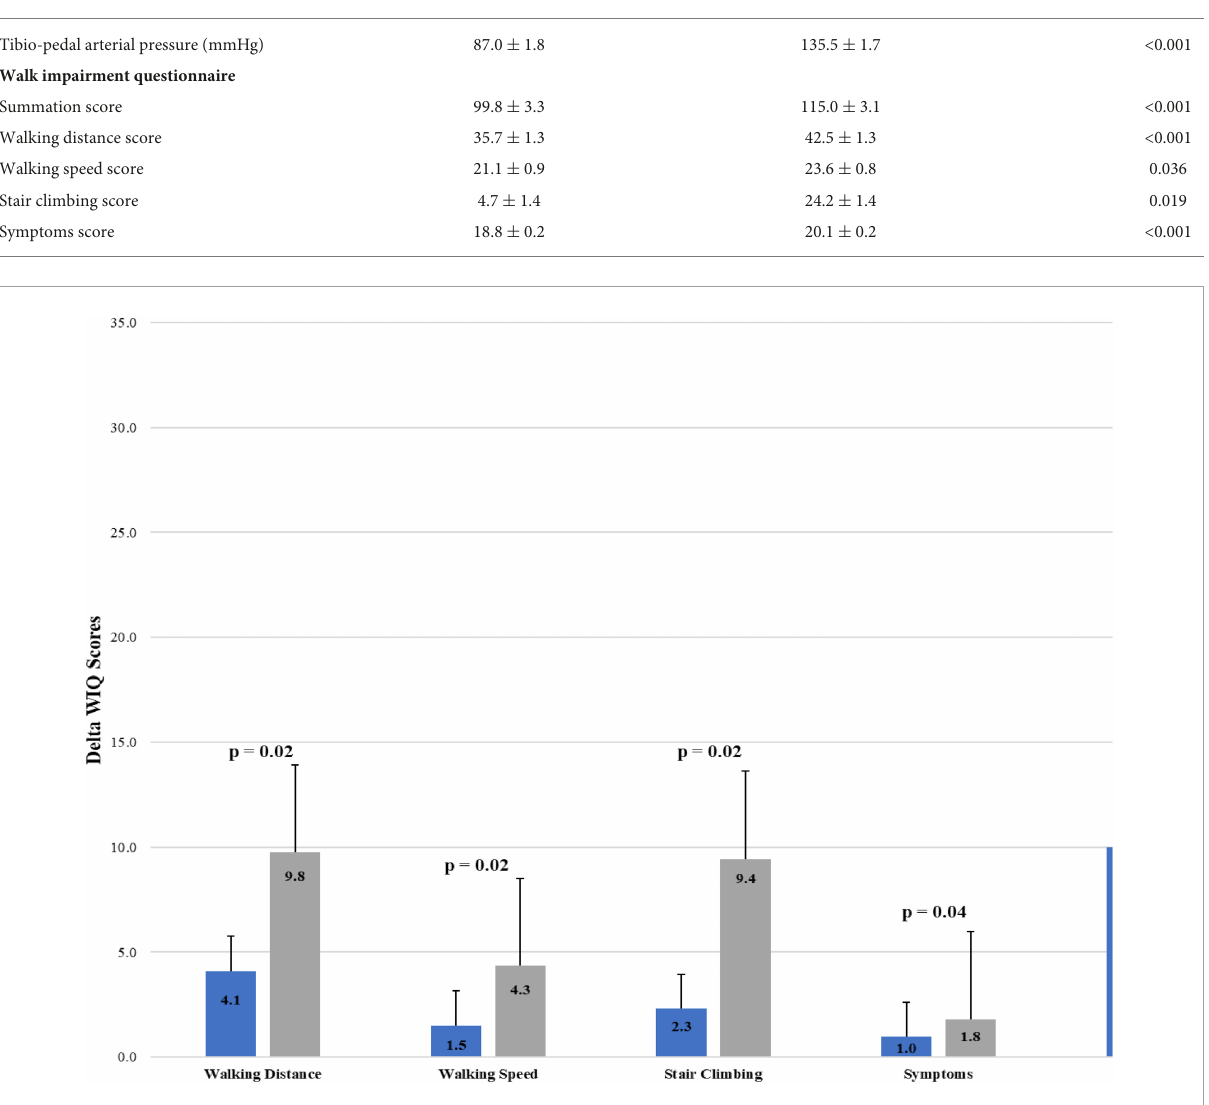
FIGURE1 Comparing the delta walking impairment questionnaire (WIQ) scores (summation, walking distance, walking speed, stair climbing, symptoms) to increase of tibio-pedal arterial pressures > or ≤ 60 mmHg after intervention. Delta Walking Impairment Questionnaire (WIQ) Scores = 30-day post-intervention score minus pre-intervention